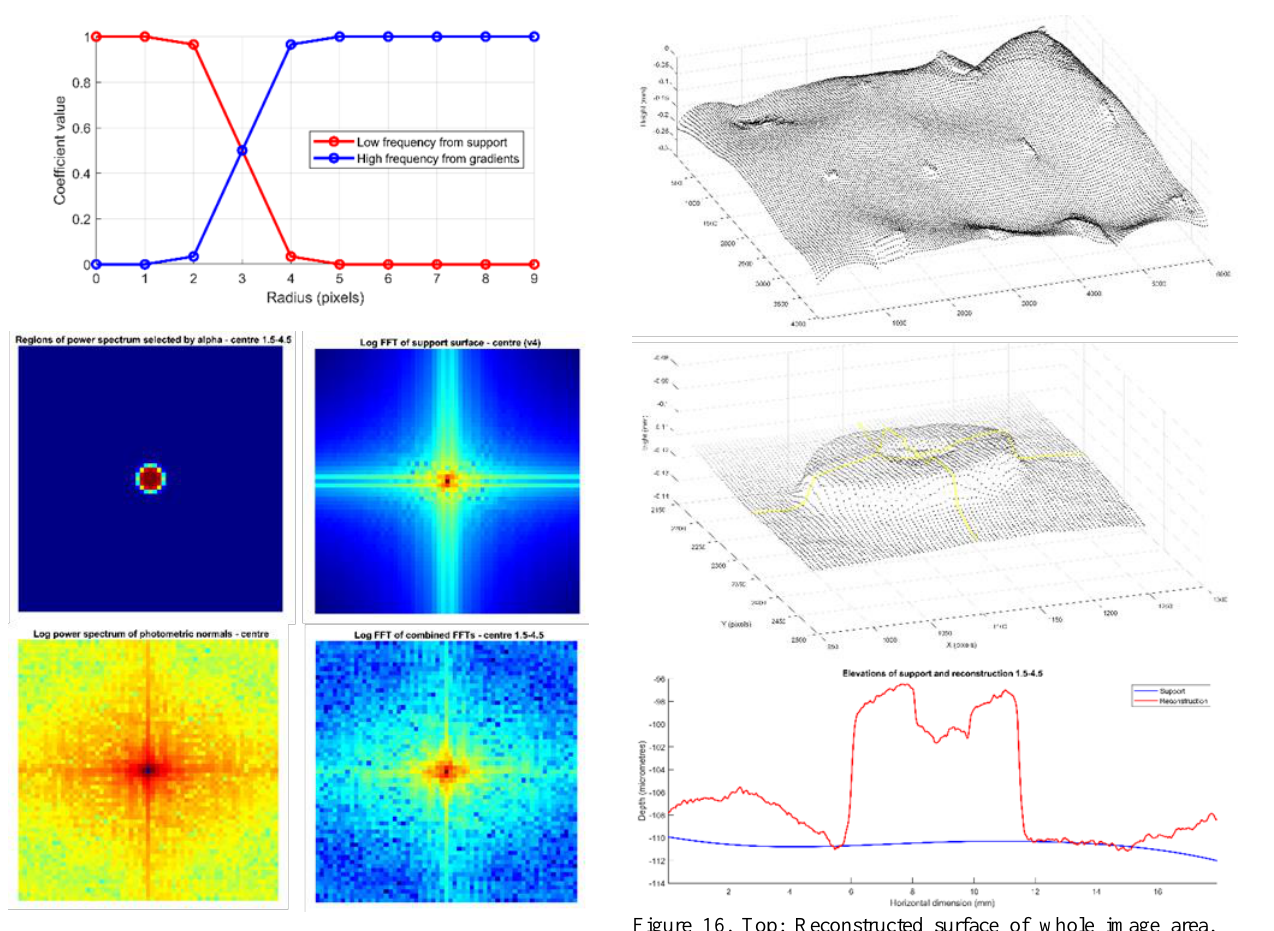
Figure 15. Top: Blending functions showing cross-over. 61x61 pixel regions at centre of shifted spatial frequency plane: Middle left: Blending function radial alpha factor selecting low frequencies in centre (red) and high frequencies in periphery (blue); Middle right: Low frequency from support surface; Bottom left: High frequency from photometric gradients; Bottom right: Combined frequencies.